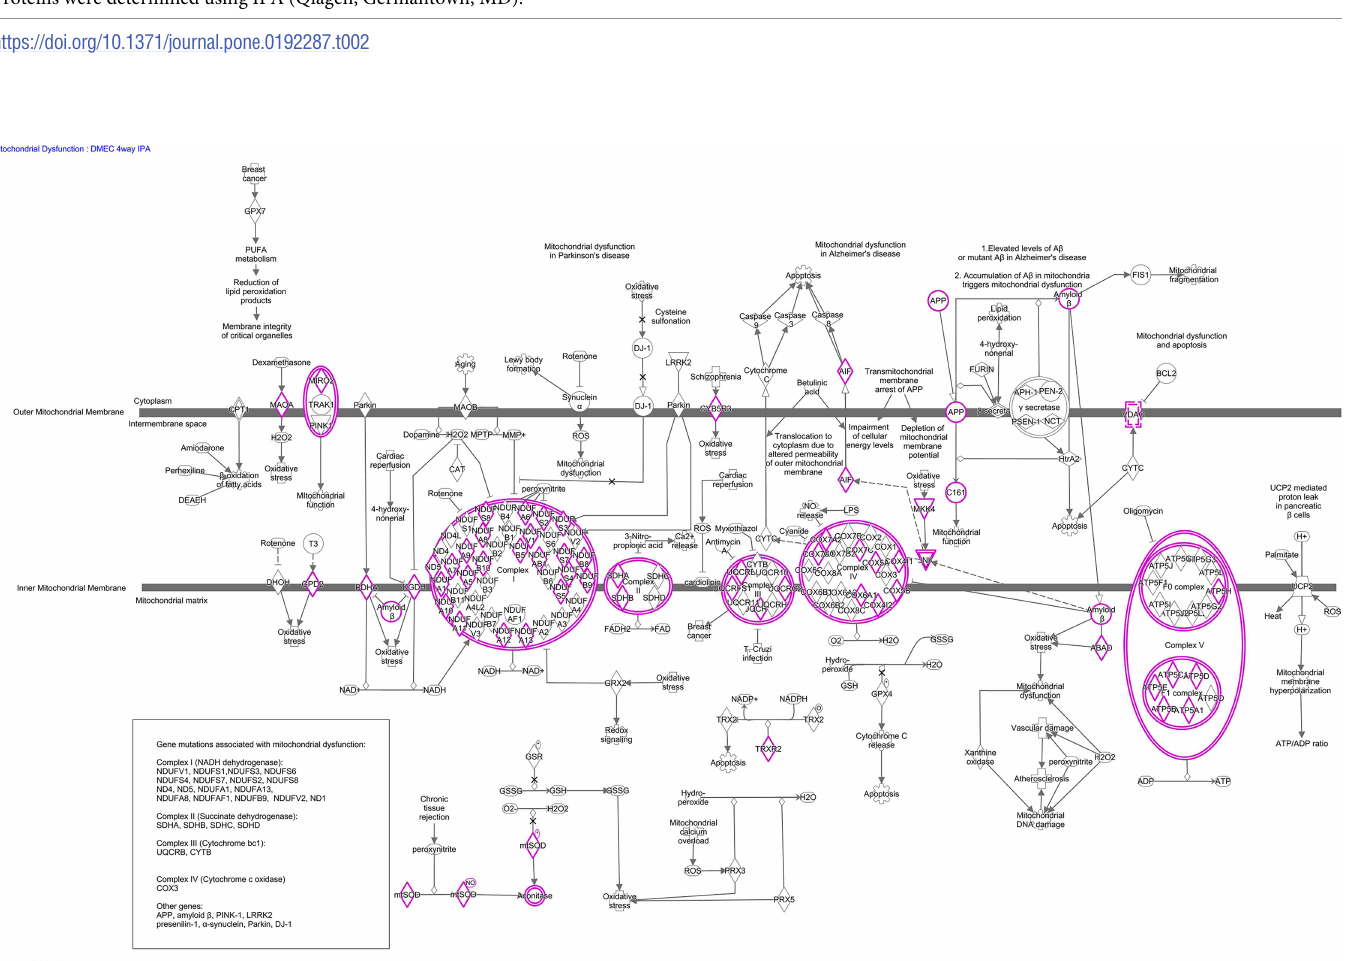
Fold changes are given for all individual comparisons. P-values are given for 4-way ANOVA analysis while all available 2-way p-values can be found in S2 Table. Proteins were determined using IPA (Qiagen, Germantown, MD).